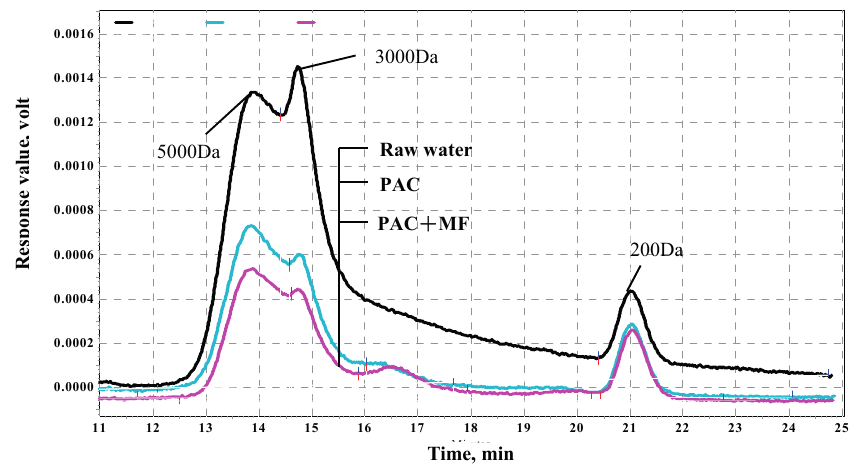
Figure 4. Effect of PAC and MF on organics molecular weight